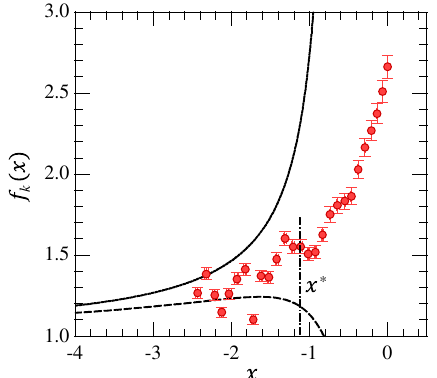
FIG. 3. Experimental data of isothermal compressibility from the BCS region to the unitarity limit. The red circles are experimental data. The dotted curve and the dashed curve show their asymptotic behavior at the BCS limit up to the first and second order of 1 =x , respectively. The vertical dash-dotted line indicates interaction parameter x (cid:4) , where superfluid transition occurs. The fermions are in the superfluid state in the region of x > x (cid:4)